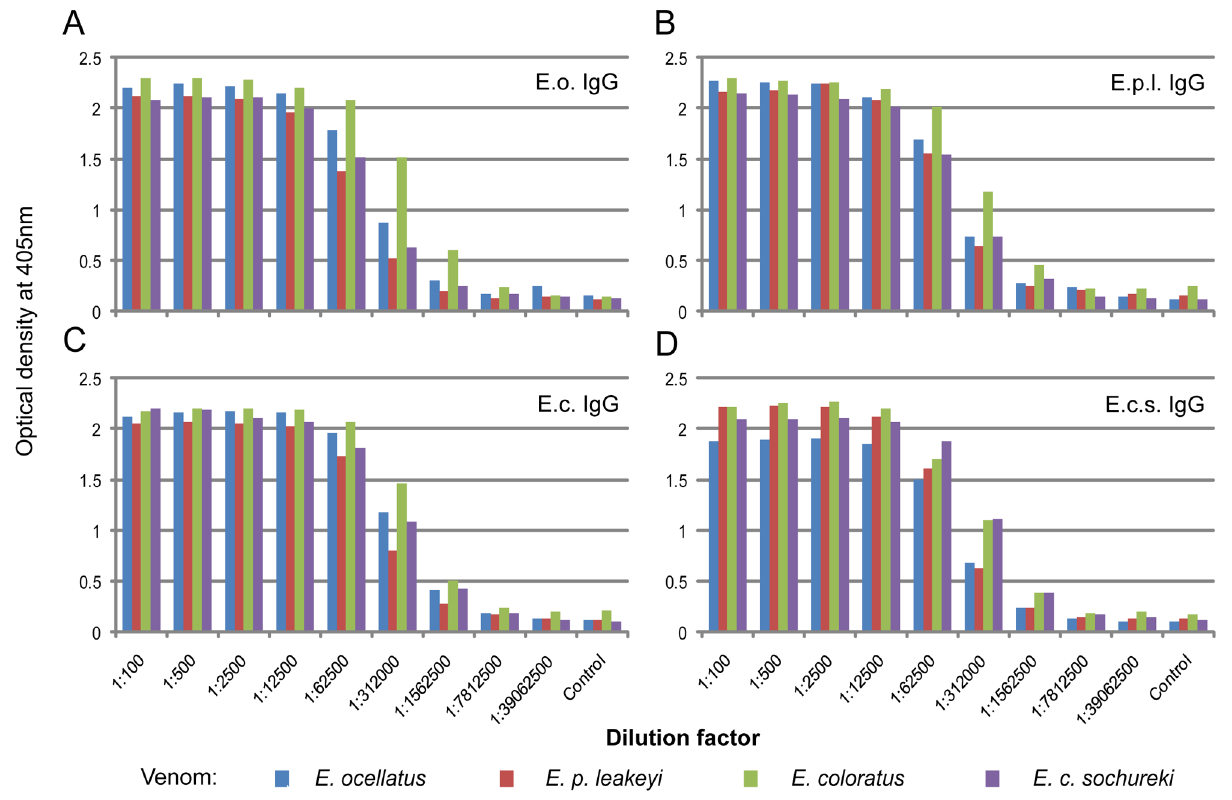
Figure 3. Extensive cross-specific immunological reactivity between Echis venoms and Echis species-specific IgG antisera revealed by End Point Titration ELISA. Venom from E. ocellatus (blue bars), E. p. leakeyi (red bars), E. coloratus (green bars) and E. c. sochureki (purple bars) were incubated with serial dilutions (horizontal axis) of IgG antisera raised against E. ocellatus (A), E. p. leakeyi (B), E. coloratus (C) and E. c. sochureki (D) and the optical density determined (vertical axis).